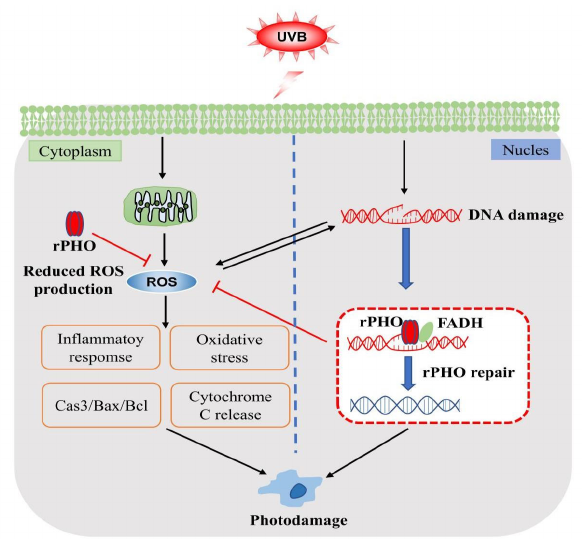
Figure 10. Mechanisms involved in protective effects of rPHO.